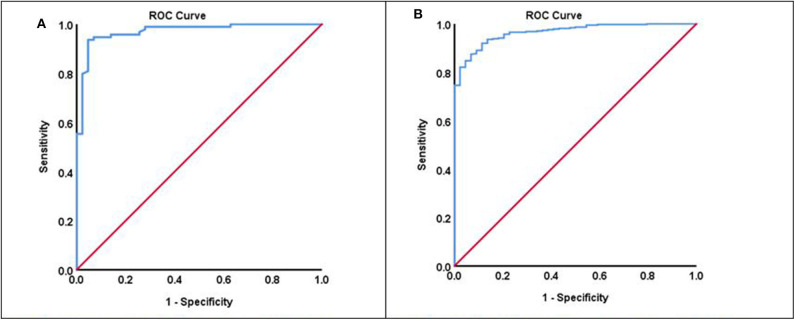
(A) ROC curve of the group “living alone” (ROC AUC: 0.971). (B) ROC curve of the group “living with family” (ROC AUC: 0.966).